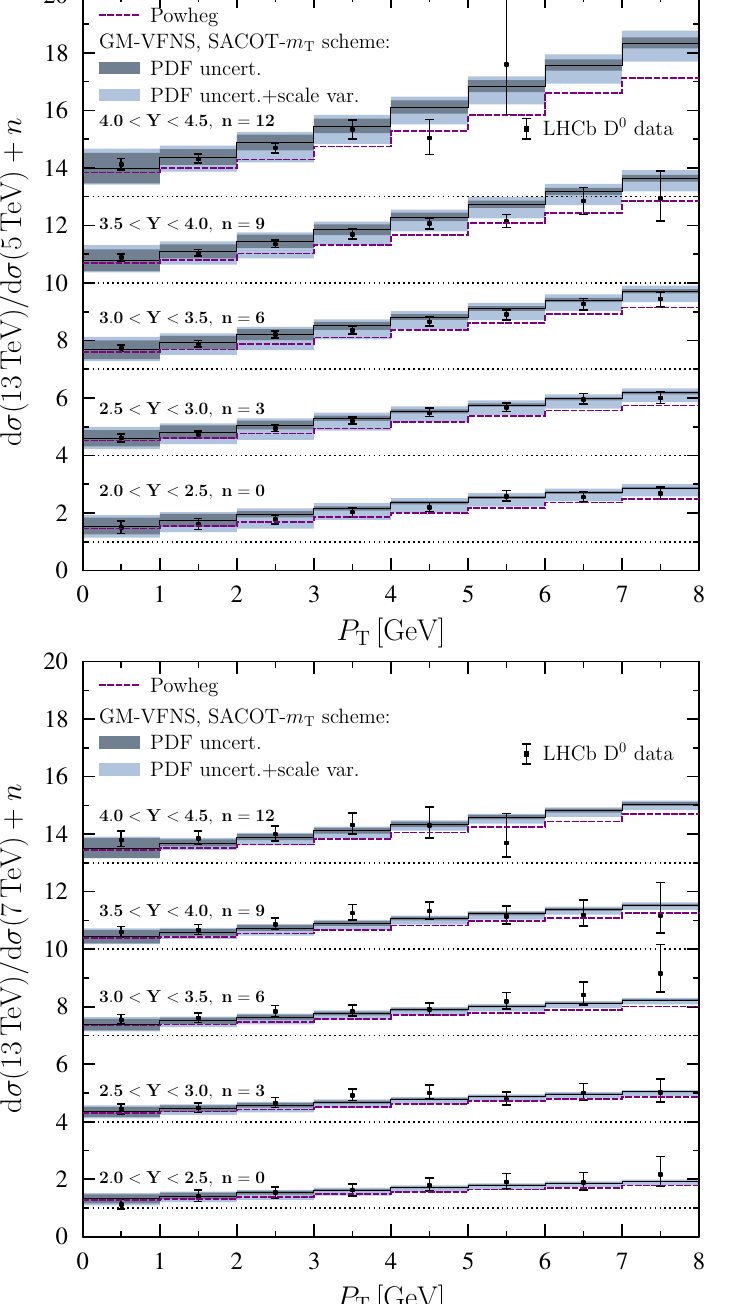
Figure 13 . A comparison of the LHCb D 0 + D 0 data [2, 3] for cross-section ratios with the GM-VFNS and Powheg calculations. The black lines indicate the central GM-VFNS results, the PDF uncertainties are shown as darker bands, and the light-blue band is the PDF uncer- tainty and scale variation added in quadrature. The purple dashed line is the central result from Powheg calculation.